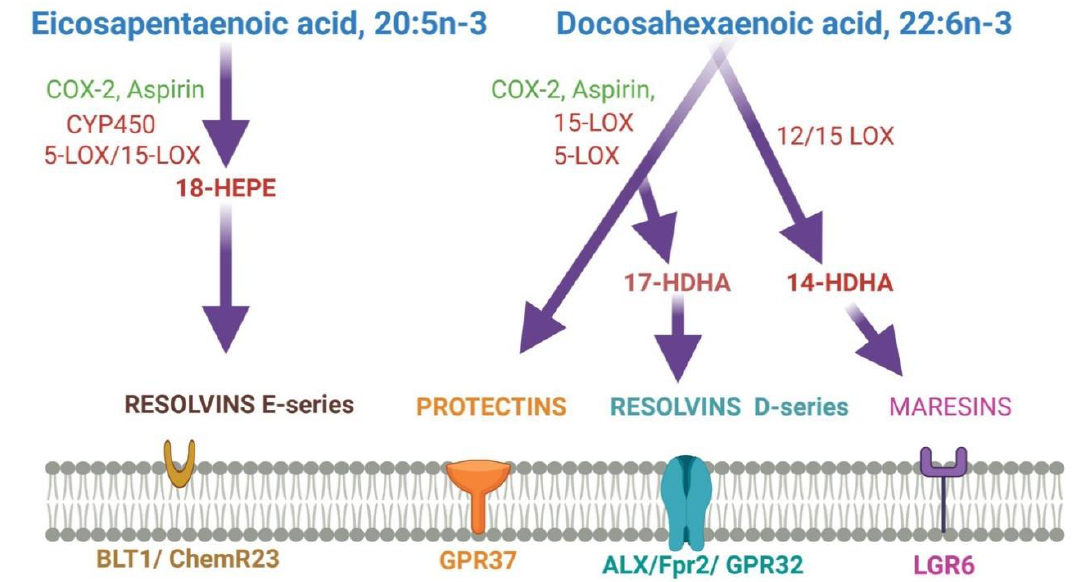
Figure 2. Metabolites of EPA and DHA, and their membrane receptors. DHA is converted to maresin 1(MaR1), neuroprotectin D1(NPD1), and resolvins by human 12-LOX, 15-LOX, and CYP or enzymatically by aspirin-treated COX-2. They play various functions in the brain. DHA is metabolized by the P450 system, cyclooxygenase,